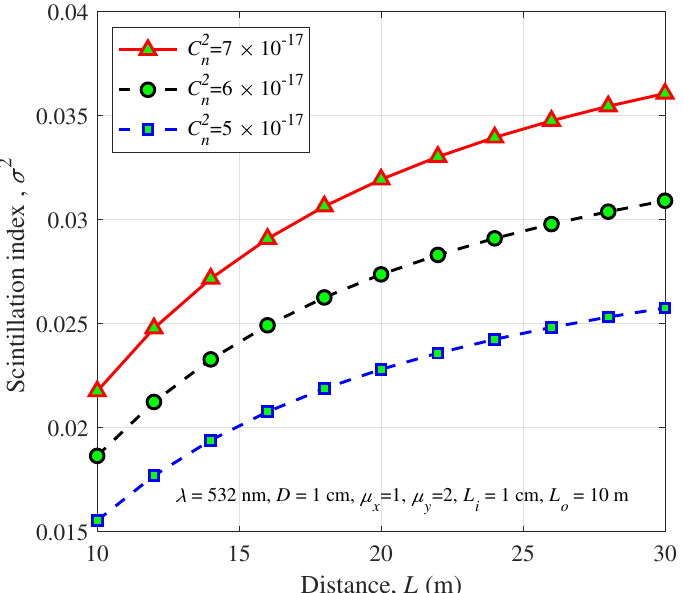
Figure 12. Scintillation index of a spherical wave versus the propagation distance for different structure